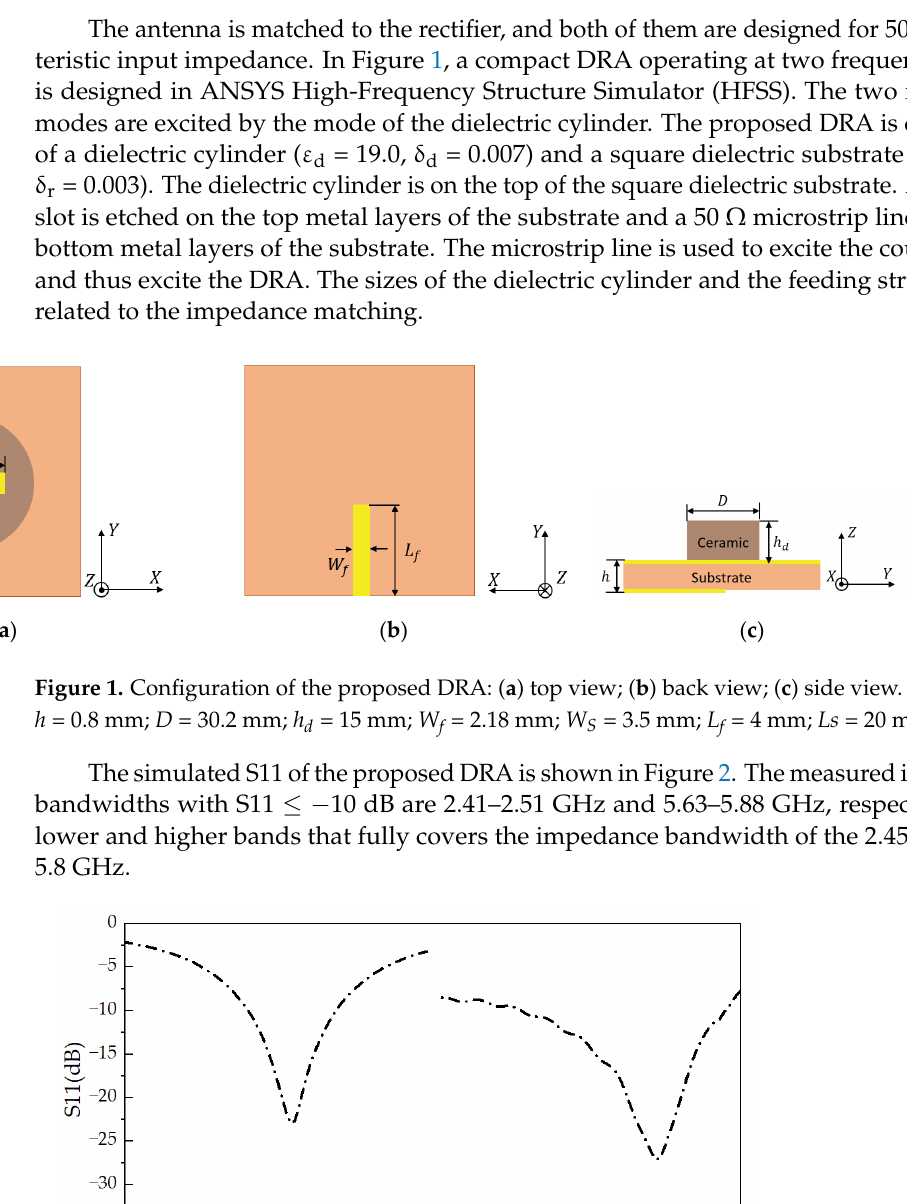
( b ) Figure 3. Electric field distributions on the x ‐ z plane: ( a ) 2.45 GHz; ( b ) 5.8 GHz. ( a ) ( b ) Figure 4. Simulated radiation patterns of the proposed DRA: ( a ) 2.45 GHz; ( b ) 5.8 GHz.